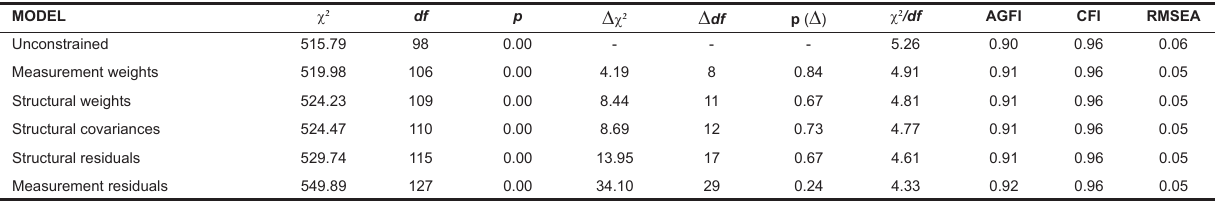
TABLE 4 Model fit statistics for the two samples of the